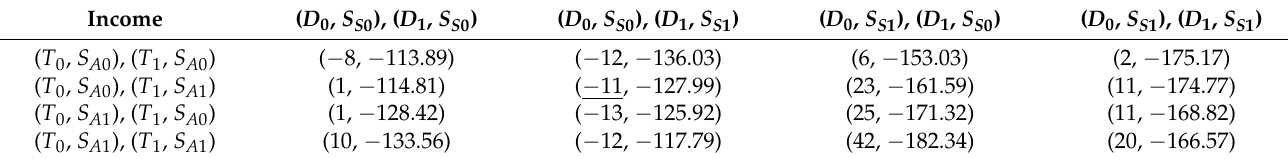
Table 10. The Income Matrix without a Pure-Strategy Nash